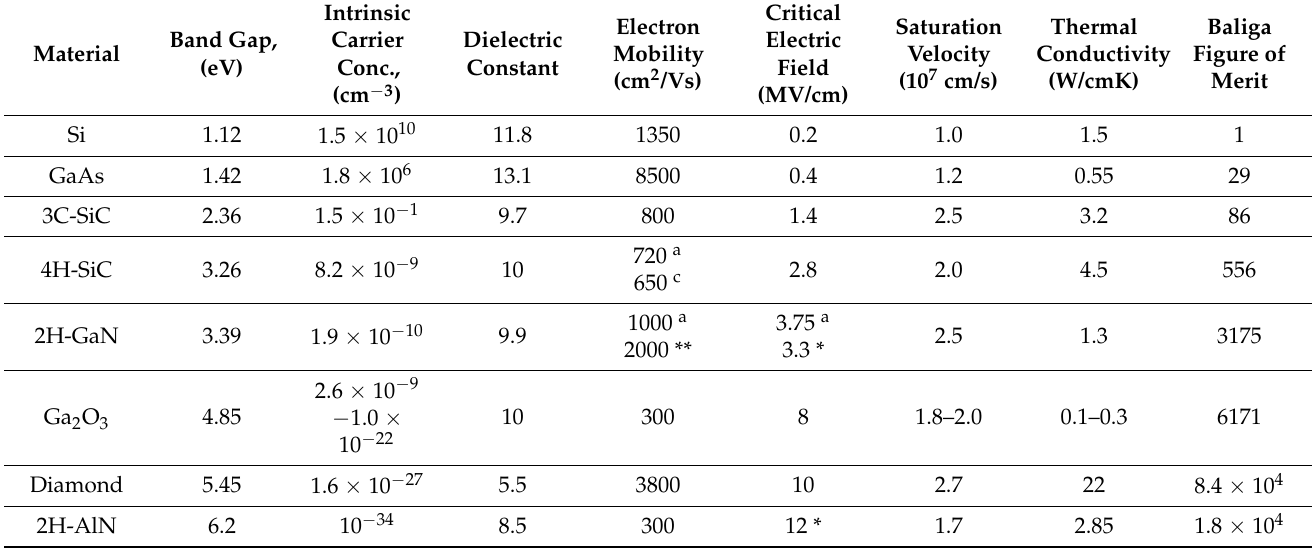
Table 1. Appropriate physical and electrical properties of cubic silicon carbide (3C-SiC) compared to other wide bandgap materials (data taken at 300